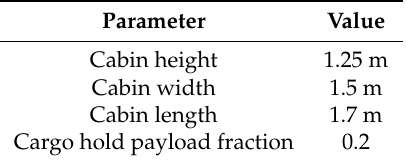
Table 4. Additional requirements for the cabin of an ACT/FHS like rotorcraft.